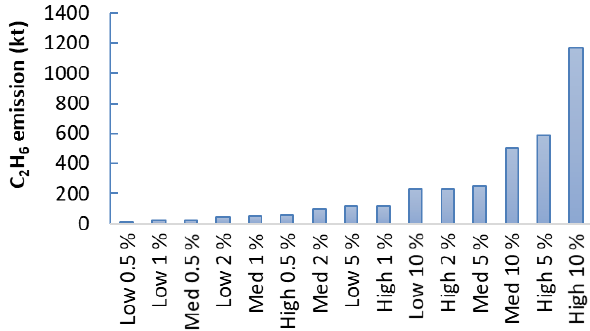
Figure 3. Ethane emissions from all European shale gas plays con- sidered under varying production and leakage scenarios; Low, Med and High indicate low, medium and high production scenarios. The percentages indicate the assumed upstream leakage of